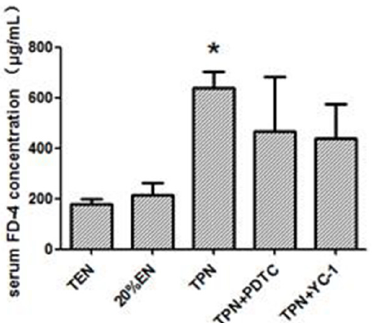
Figure 9. Serum FD-4 level assay of in vivo test of epithelium permeability among groups. Compared with TEN, only the TPN group had statistically higher epithelium permeability for the FD-4 molecule ( p = 0.039). There were increasing trends of epithelium permeability in both TPN+PDTC and TPN+YC-1 groups compared with TEN, but no statistical significance was found. * p < 0.05, compared with TEN group.